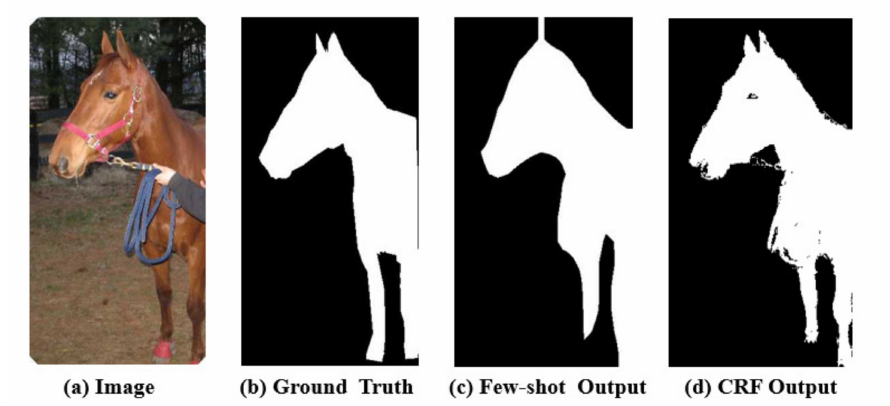
Figure 6. Comparison of segmentation e ff ect. ( a ) The original image. ( b ) The ground truth of the image. ( c ) The segmentation result after few-shot guided network. ( d ) The final output after the fully connected conditional random field (CRF)